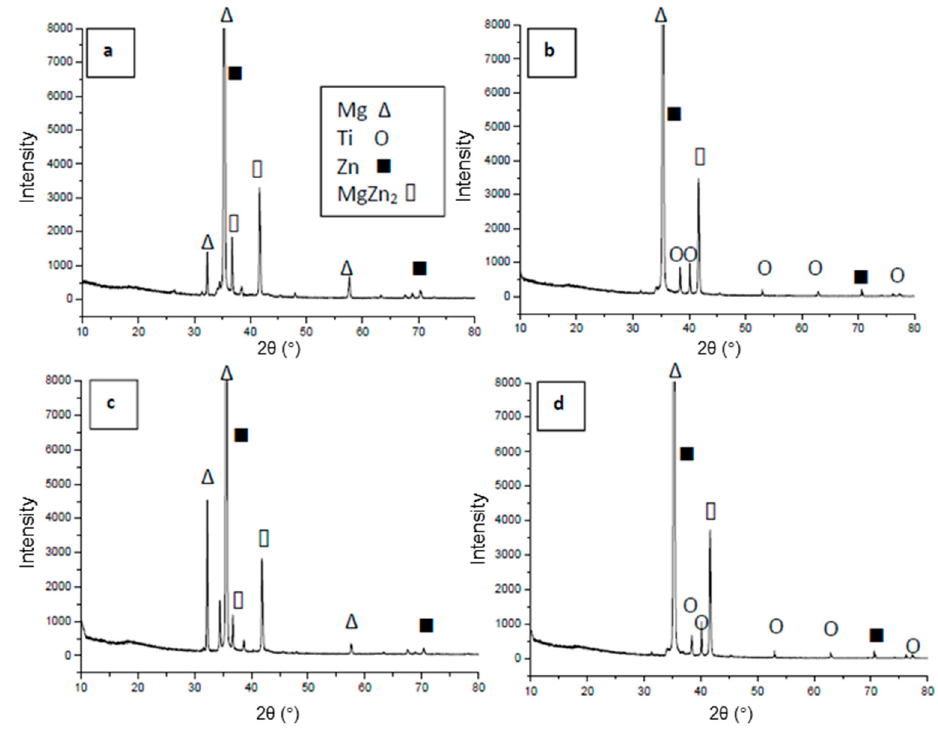
Figure 10. XRD patterns of the fractured surfaces for the bond made at 5 min. ( a ) Mg side and ( b ) Ti side and XRD patterns of the fractured surfaces for the bond made at 30 min. ( c ) Mg side and ( d ) Ti side.